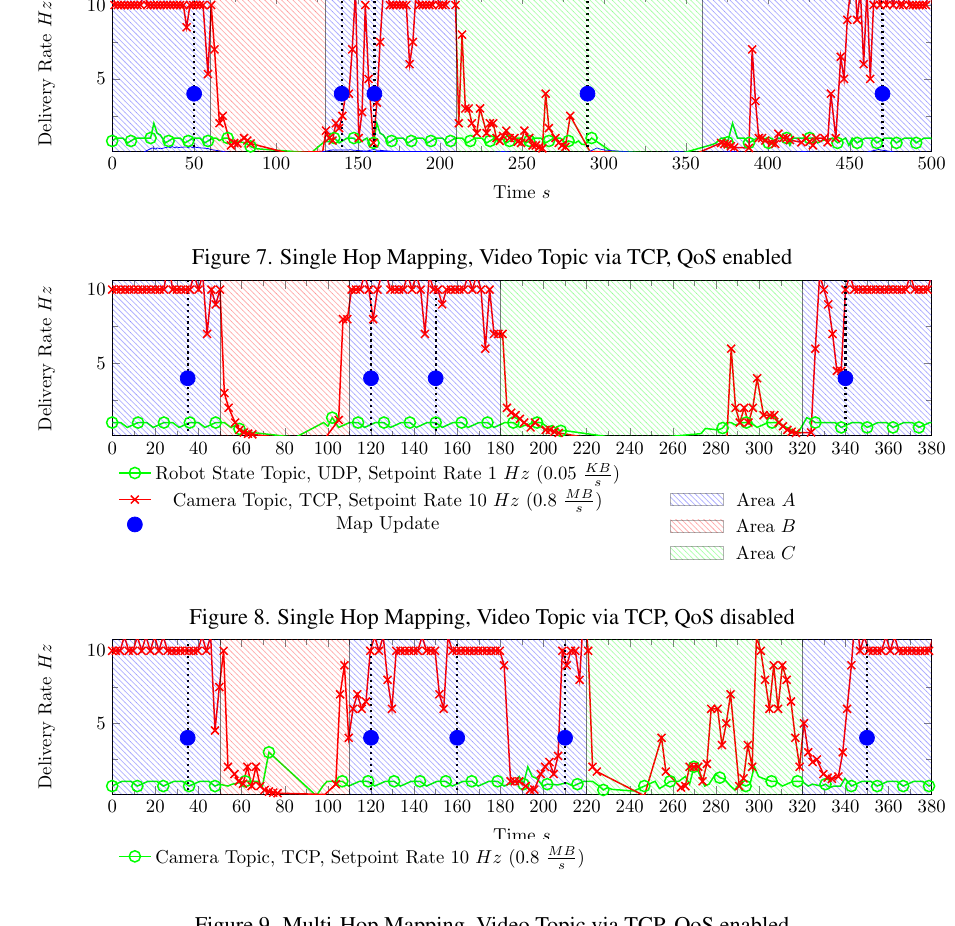
Figure 9. Multi-Hop Mapping, Video Topic via TCP, QoS enabled